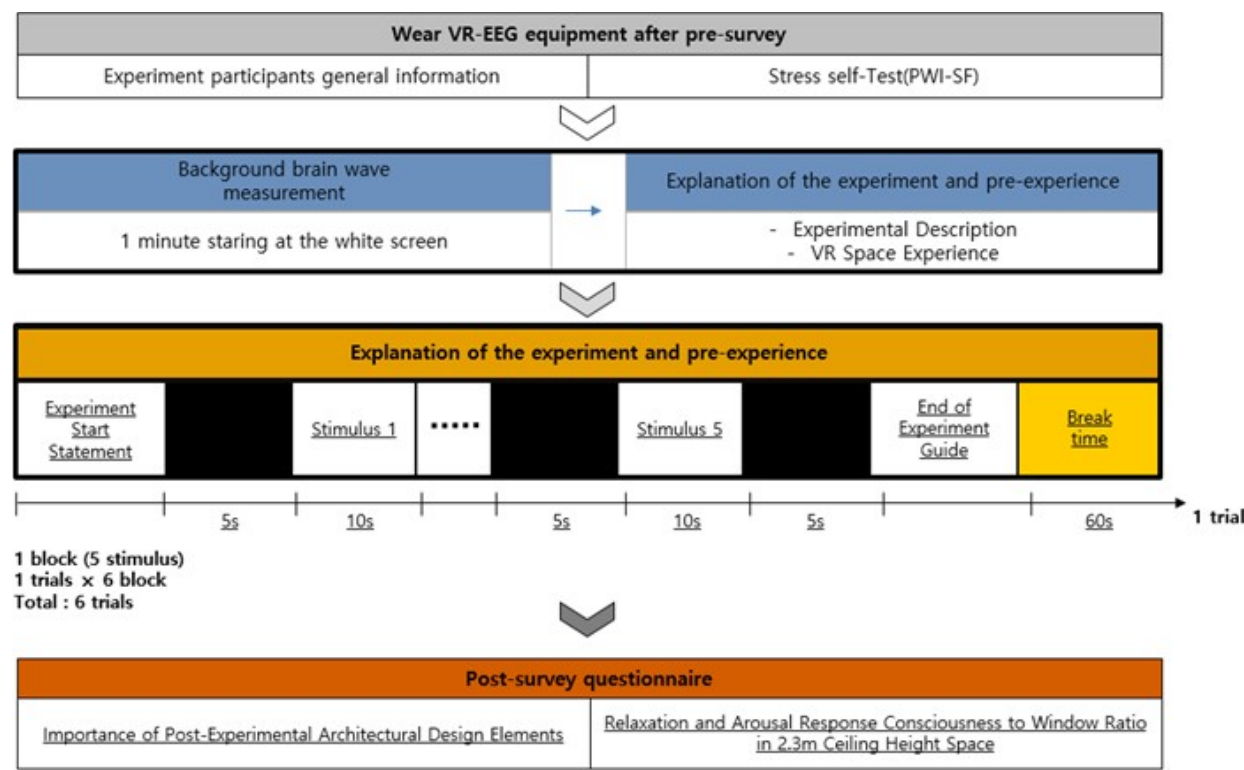
Figure 5. The procedure of an experiment.